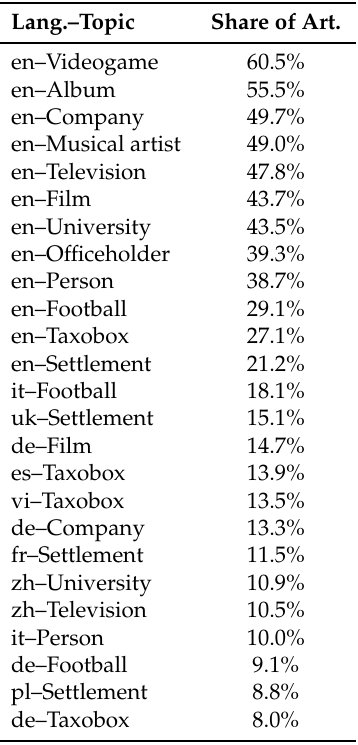
Table 9. Top 25 language–topic pairs with share of articles that have the highest quality in comparison to other languages (articles with at least three language versions were considered). Source: own